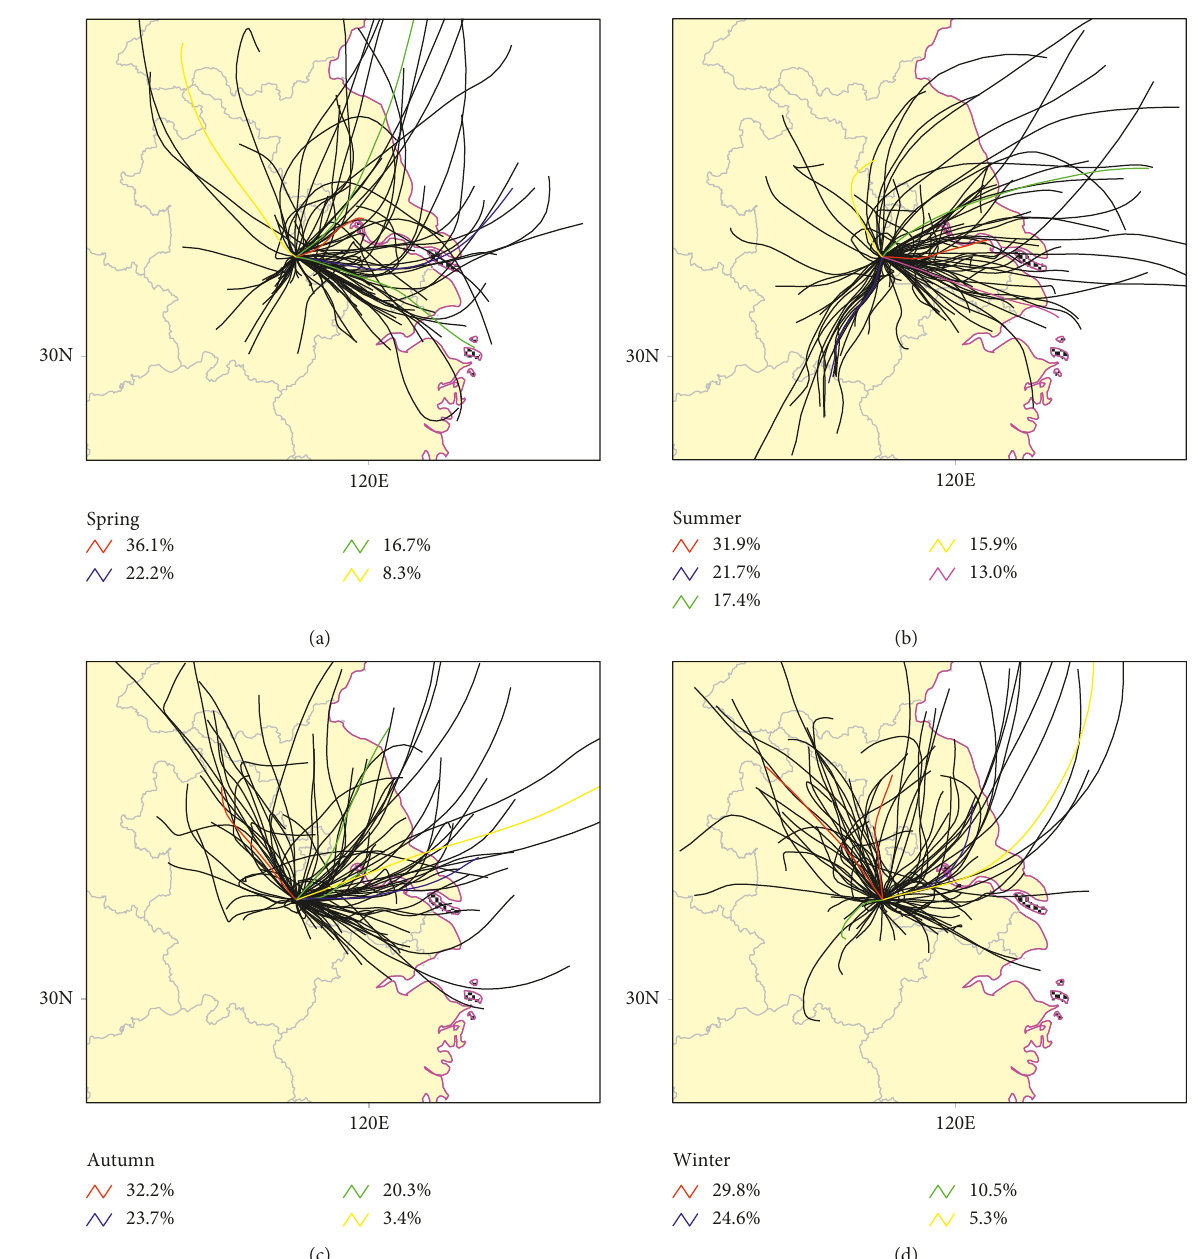
Figure 12: The cluster of air mass backward trajectories in different seasons in Ma’anshan based on the HYSPLIT model: (a) spring; (b) summer; (c) autumn; (d) winter. The black triangle represents the location of